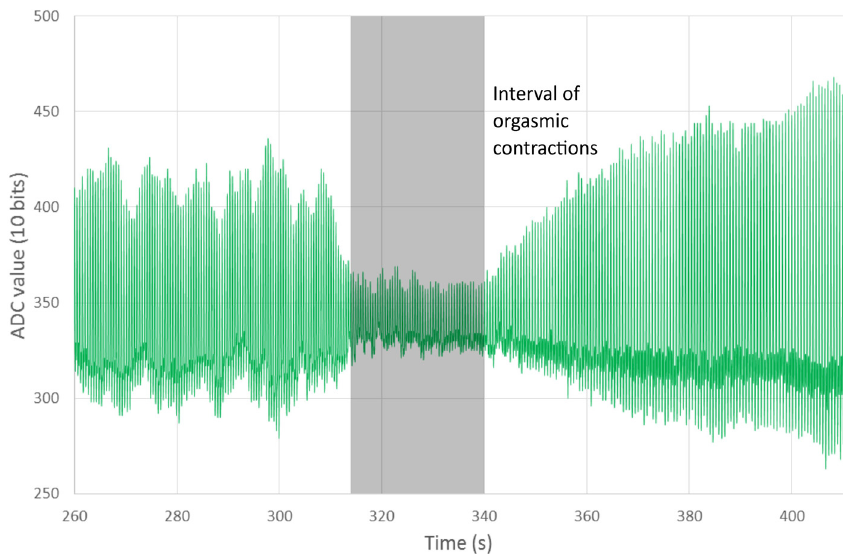
Figure 29: Pulse amplitude recorded during masturbation and